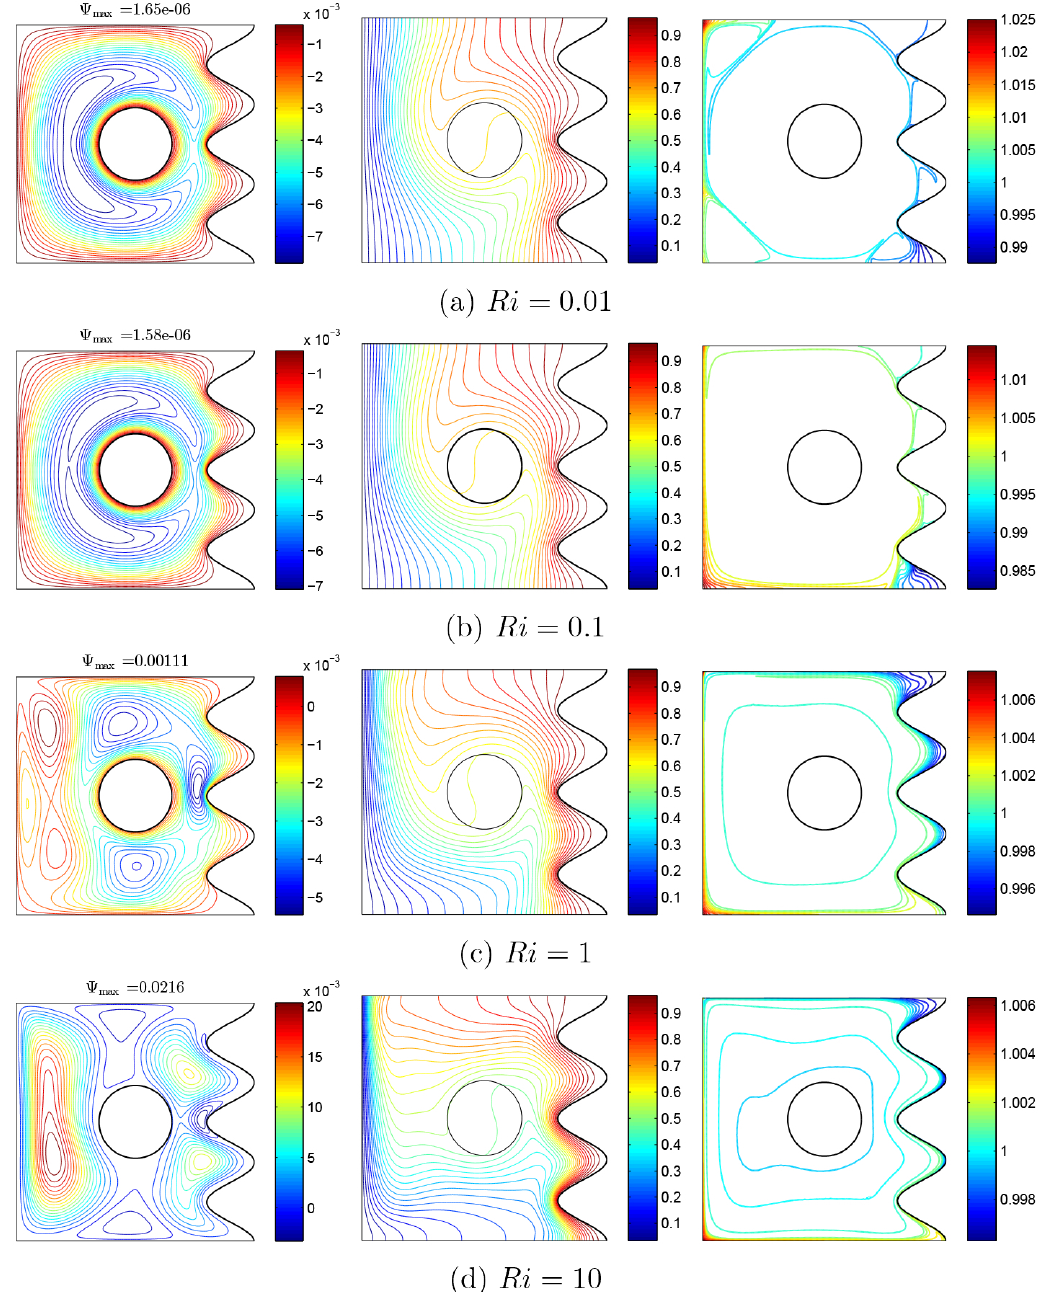
Figure 6. Variations of the ( left ) streamlines, ( middle ) isotherms, and ( right ) nanoparticle distribution evolution by Richardson number ( Ri ) for Case 1 ( Ω ), φ = 0.02, N = 3, and R =